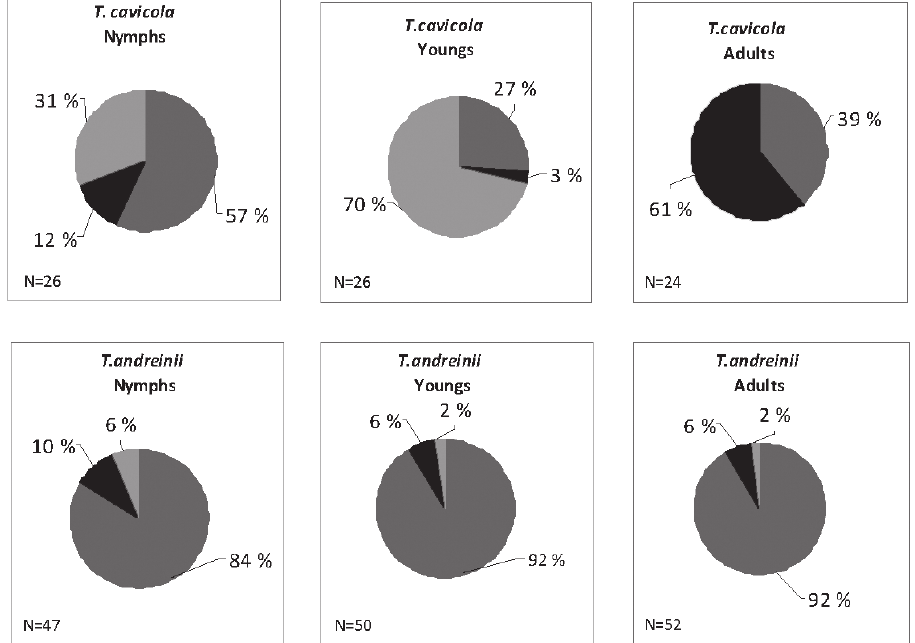
Figure 3. Comparison of the diet among age sub-samples (Young instars, Nymphs and Adults) of T. cavicola and T. andreinii . Grey: green vegetables; light grey: fibres; black: arthropod